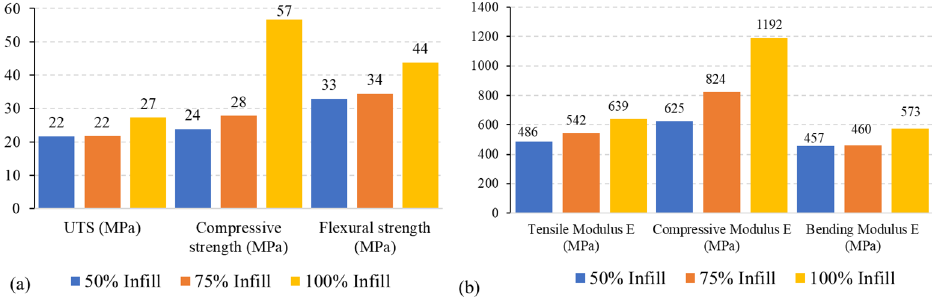
Figure 8. Effects of different infill percentages on various characteristics of ABS in ( a ) and ( b ).